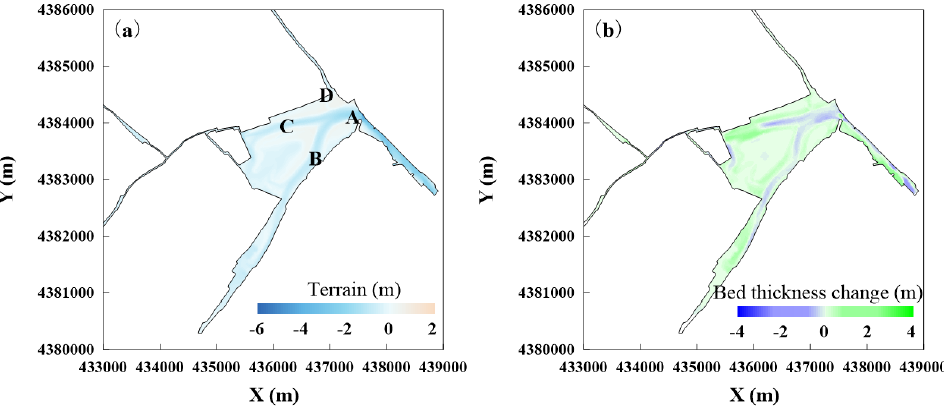
Figure 17. ( a ) Bathymetric map on 1 January 2019; ( b ) bed thickness change for the QL system from 2008 to 2018.